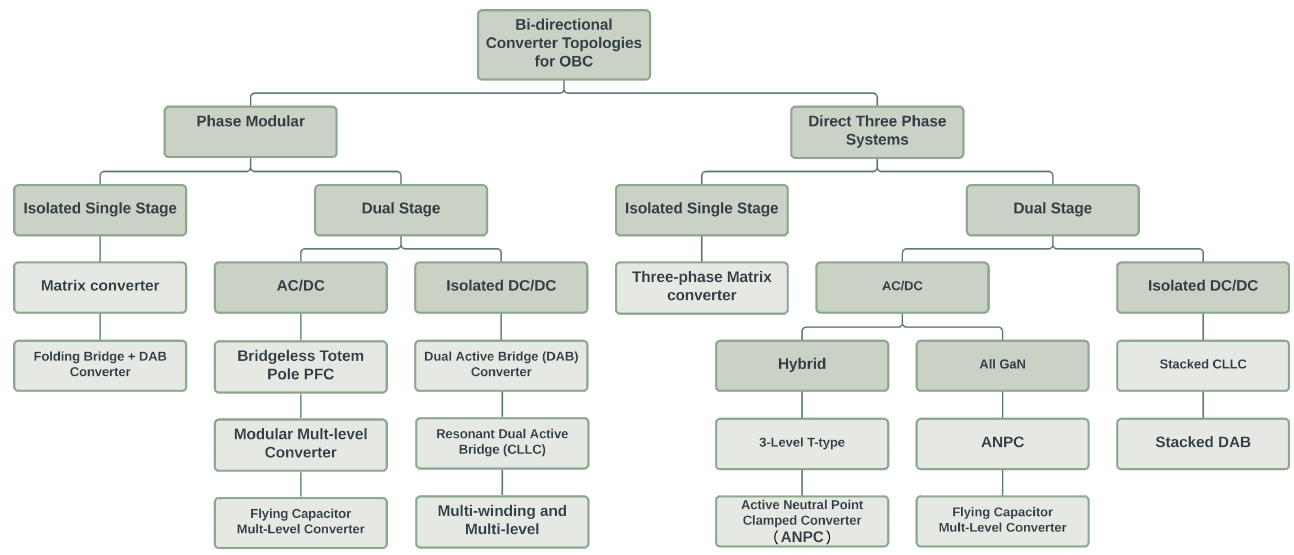
Figure 9. Classification of bi-directional converter topologies for the